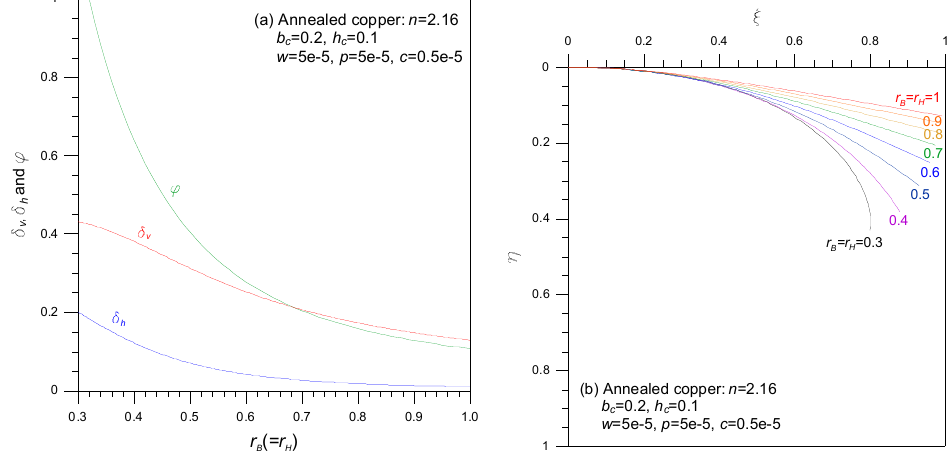
Figure 6. Effects of cross-sectional ratio on the ( a ) tip responses and ( b ) elastica of beams under combined loading.